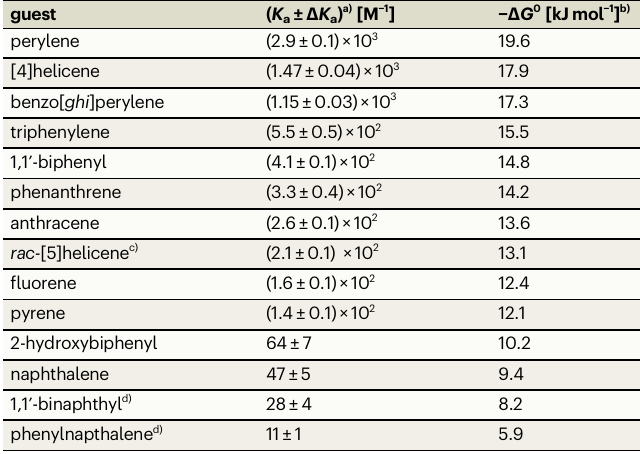
Table 1 | Binding constants for the complexation of PAHs with rac -1 determined by UV/vis or 1 H NMR titration experiments in tetrachloromethane at 295 K and Gibbs free energies for the corresponding complex formation